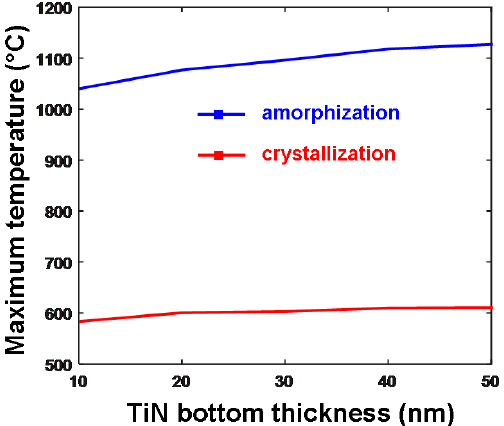
Figure 14. Maximum temperature ( ° C) as a function of the thickness of the TiN bottom layer during both crystallization and amorphization processes. Reproduced with permission from [36].